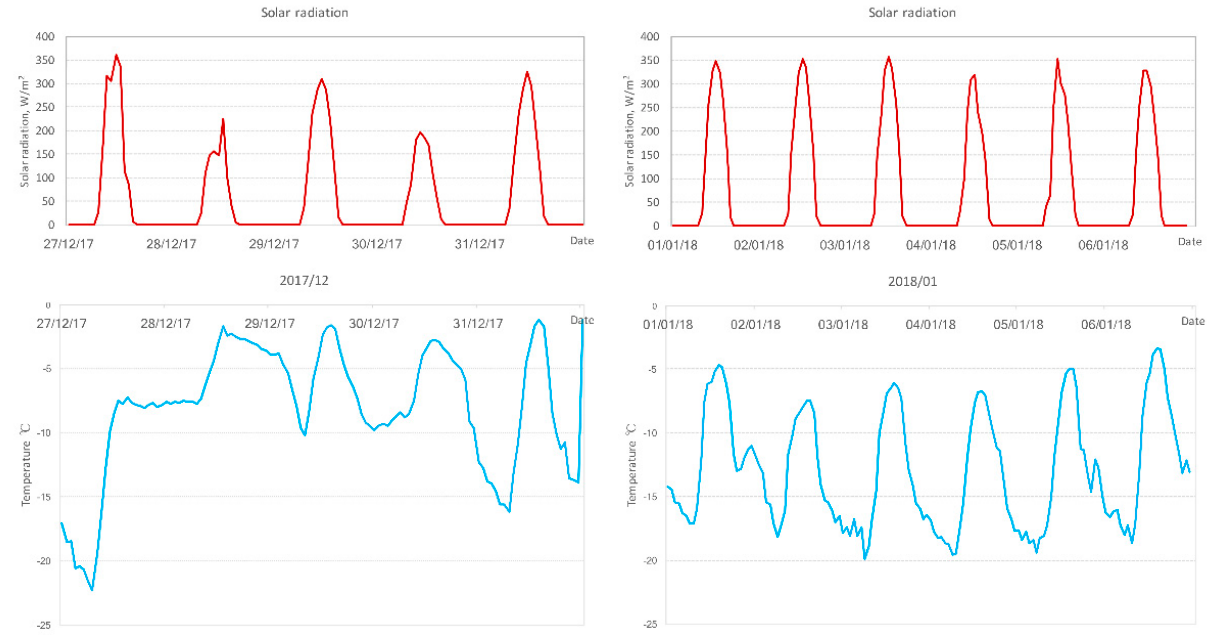
Figure 3. External climatic conditions during clear days (27–31 December 2017) and cloudy days (1–6 January 2018).